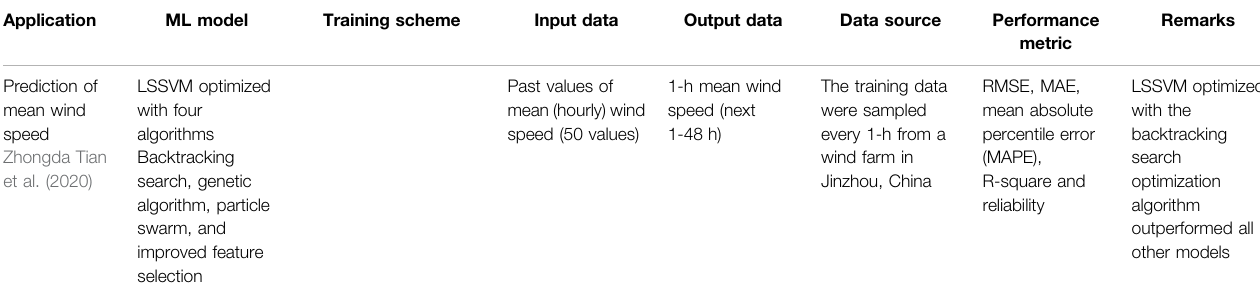
TABLE 1 | ( Continued ) Summary of ML applications for classical boundary-layer